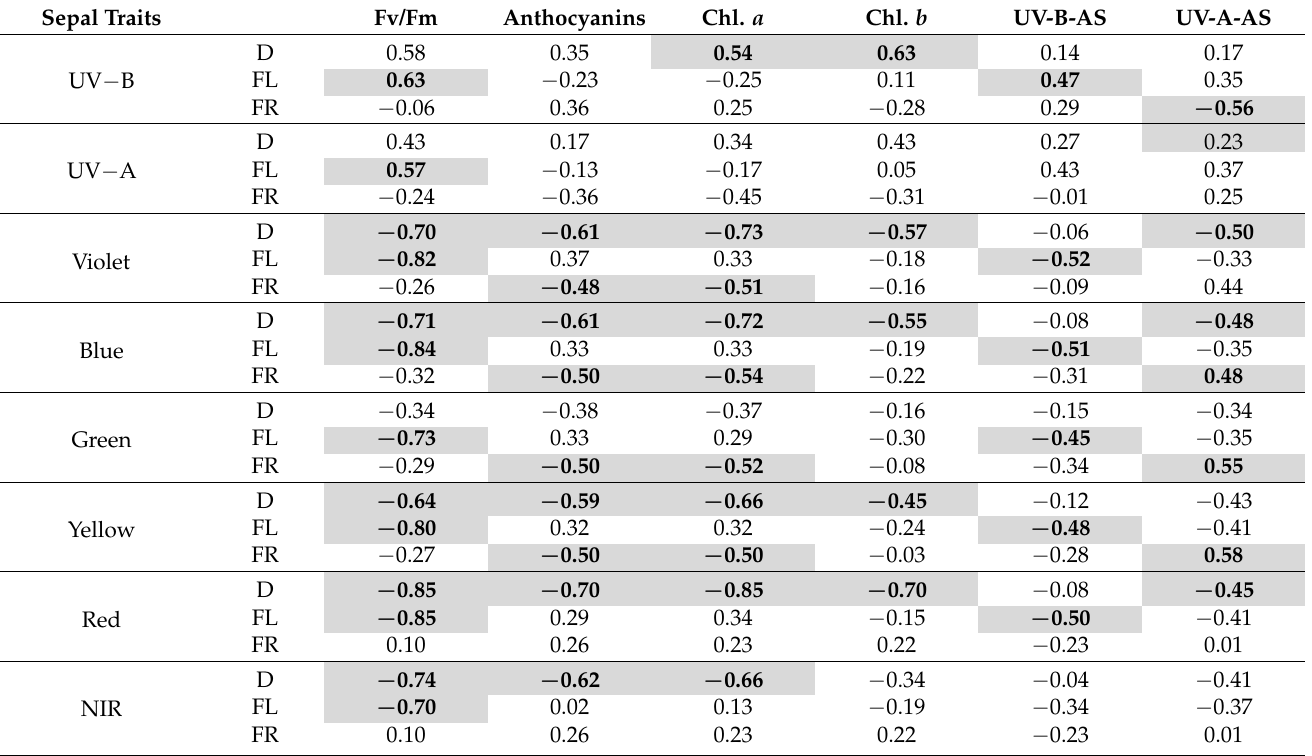
Table 2. Correlations between sepal reflectance in the different regions of the spectrum and some of the other measured H. niger and H. odorus sepal traits for each of the three different developmental phases. Significant correlations are indicated in bold ( p ≤ 0.05; Pearson’s